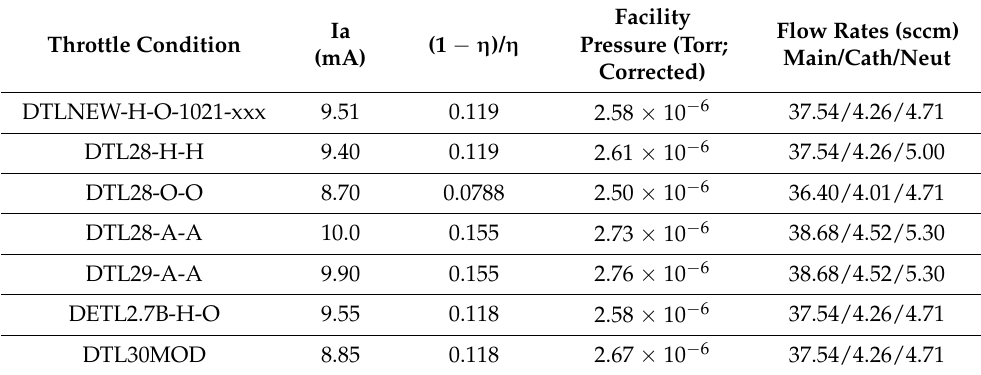
Figure 5. Relative peak molybdenum density at grid center as a function of throttle condition. Nominal ion beam ( V b ) and absolute value accelerator grid voltages ( | V a | ) are as shown, with throttle condition labels underneath. Table 1 provides additional information. Table 1. Engine parameters for Figure 5 throttle